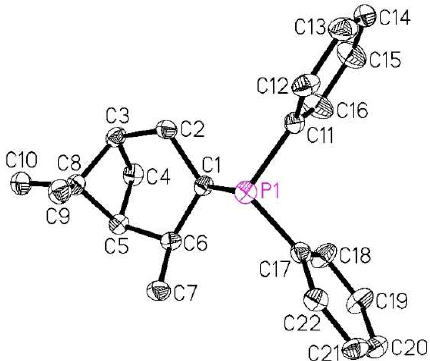
Figure 1. Molecular structure of NISPCDPP ( 9 ) in the crystal. Hydrogen atoms are omitted for clarity. Displacement ellipsoids correspond to 30% probability [24].